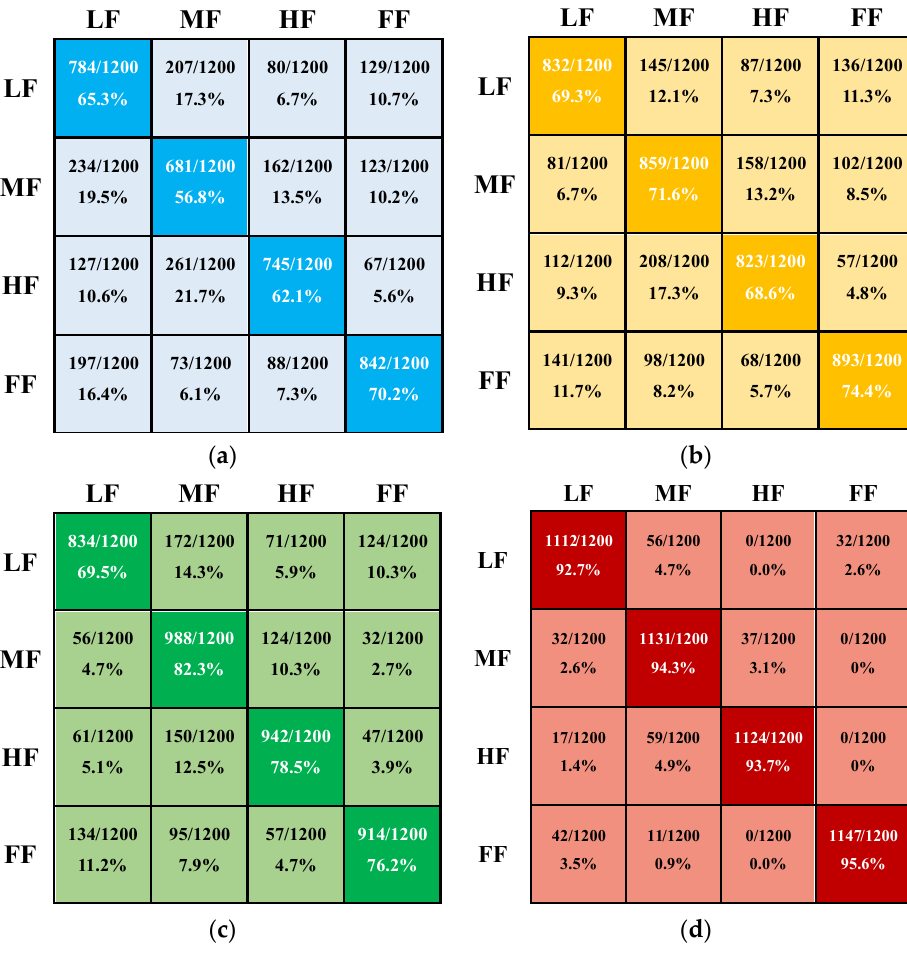
Figure 5. The confusion matrix results of the four SVM classifiers with different features. ( a ) SF-SVM, ( b ) EMDE-SVM, ( c ) VMDE-SVM, and ( d ) BearingCog-SVM.